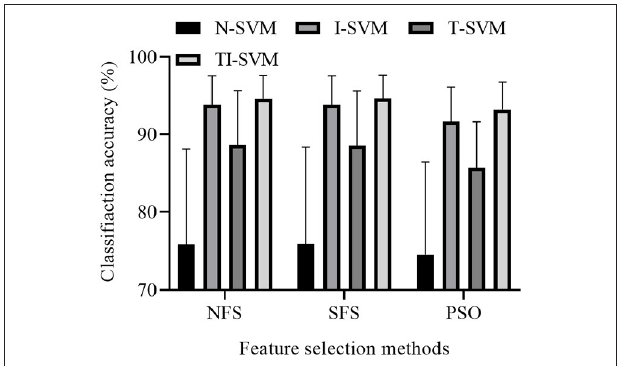
FIGURE 4 | Average classification accuracy of 12 schemes across 12